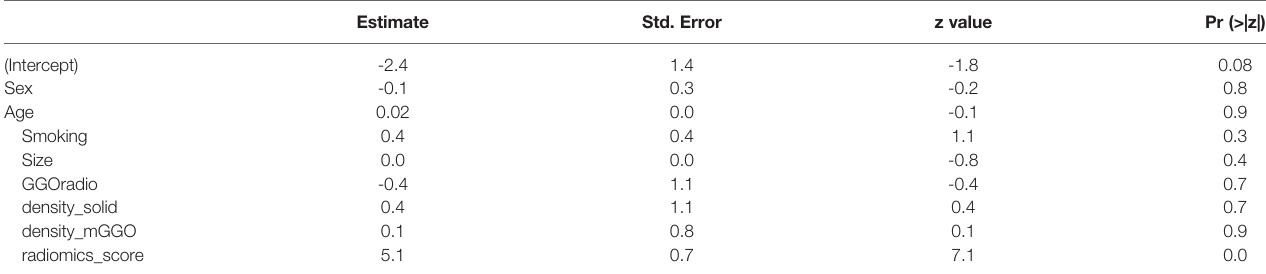
TABLE 5 | Features included in Mixmodel and their coef fi